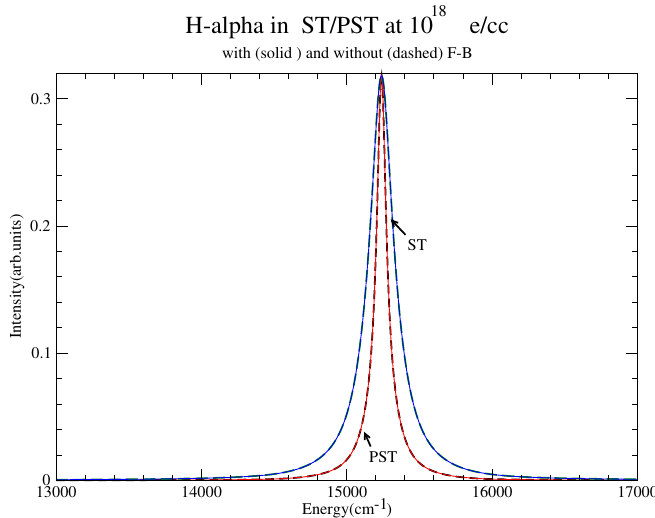
Figure 24. BB + FB vs. BB comparison for the H α line at the intermediate density. Shown CONVST for BB + FB (blue solid) and CONVST for BB + FB (red solid) and the corresponding BB only results (dashed), which are